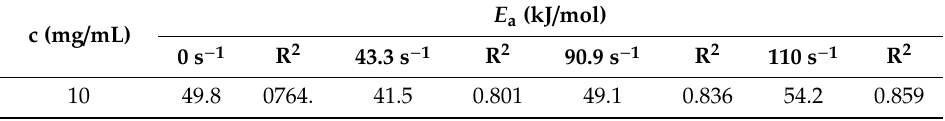
Table 4. E a value for collagen solution at di ff erent shear rates after 15 min of UV